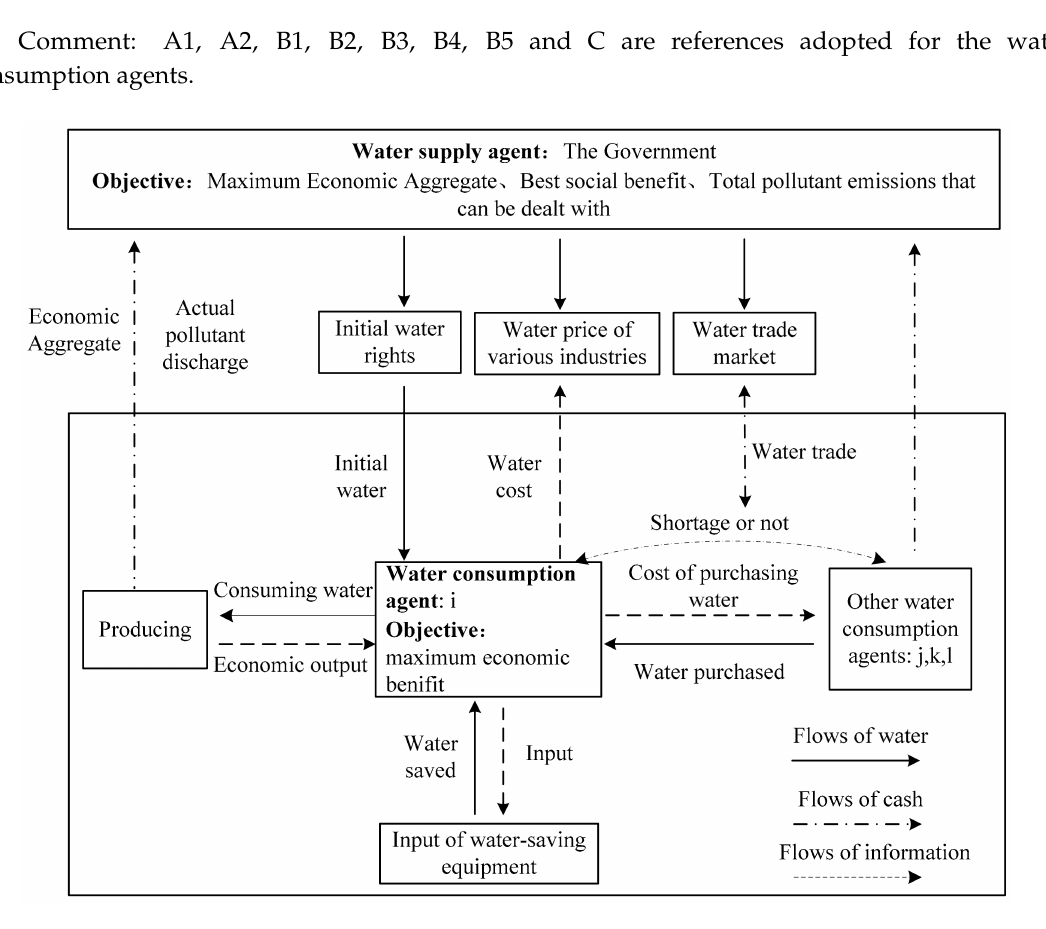
Figure 2. The overall framework for the optimal water resource allocation